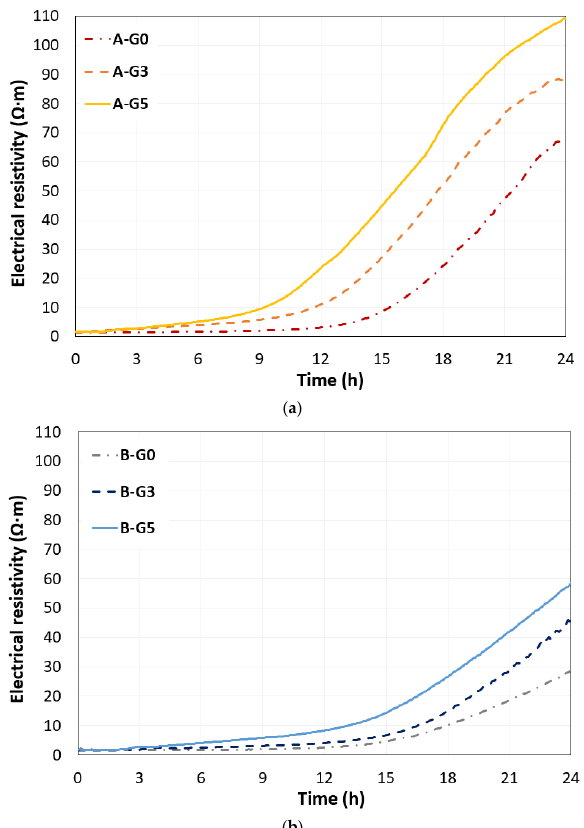
Figure 7. Electrical resistivity measurements of early-age CSA cement paste with the different gypsum contents of 0% (G0), 3% (G3), and 5% (G5) under different water-to-binder ratios ( a ) 0.5 and ( b ) 0.55.